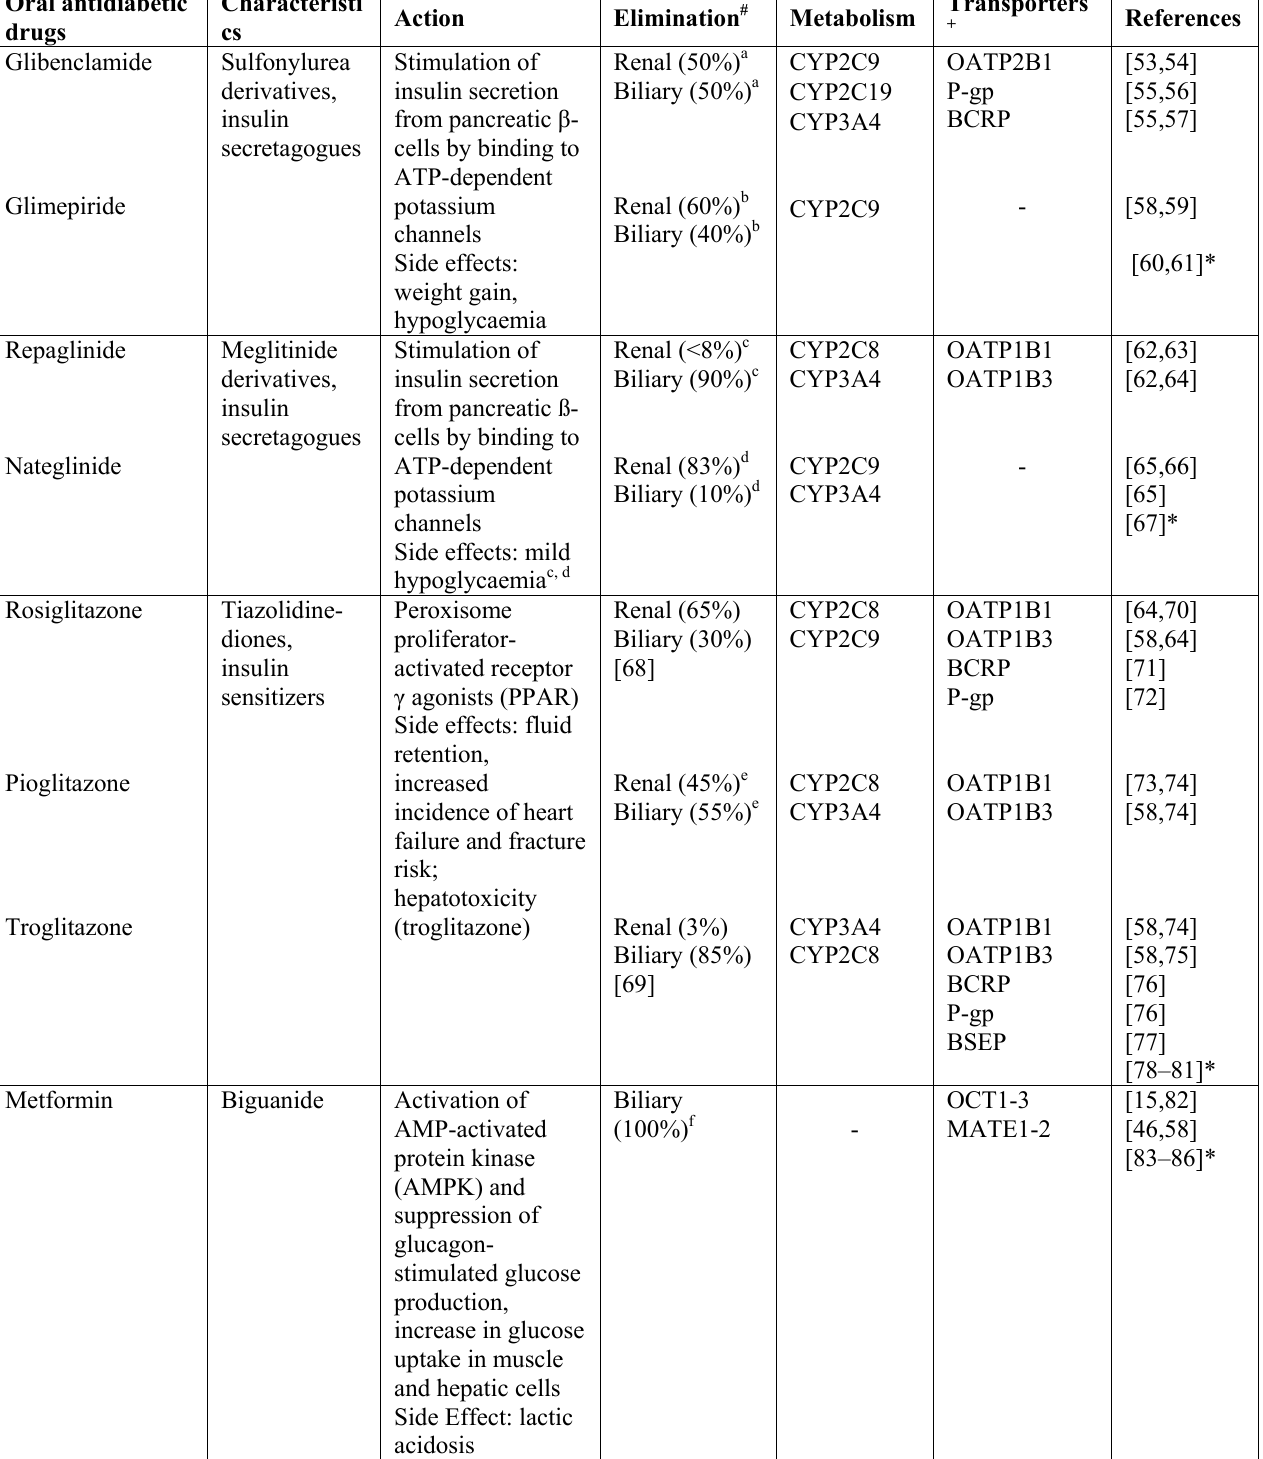
Table 1. Characteristics of selected oral antidiabetic